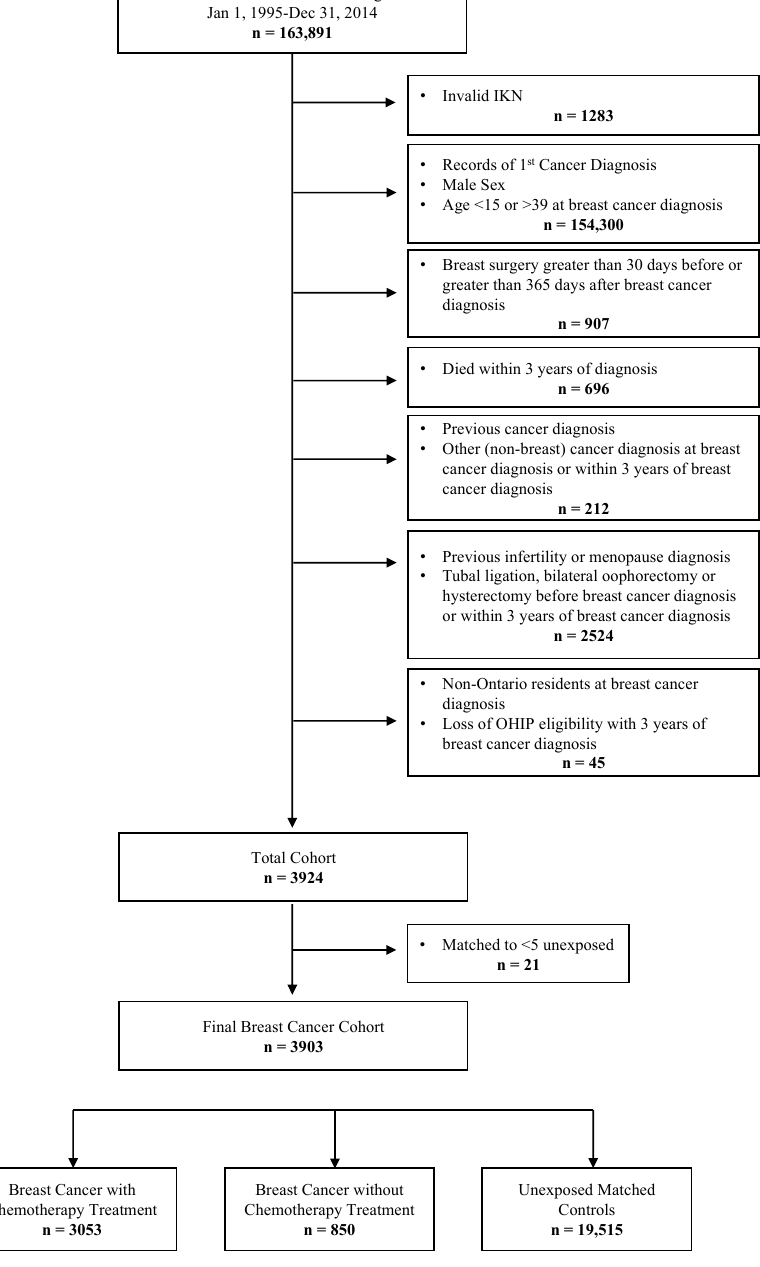
Figure 1. Flow chart demonstrating inclusion and exclusion ceiteria foe cohort design. IKN = ICES Key Number.